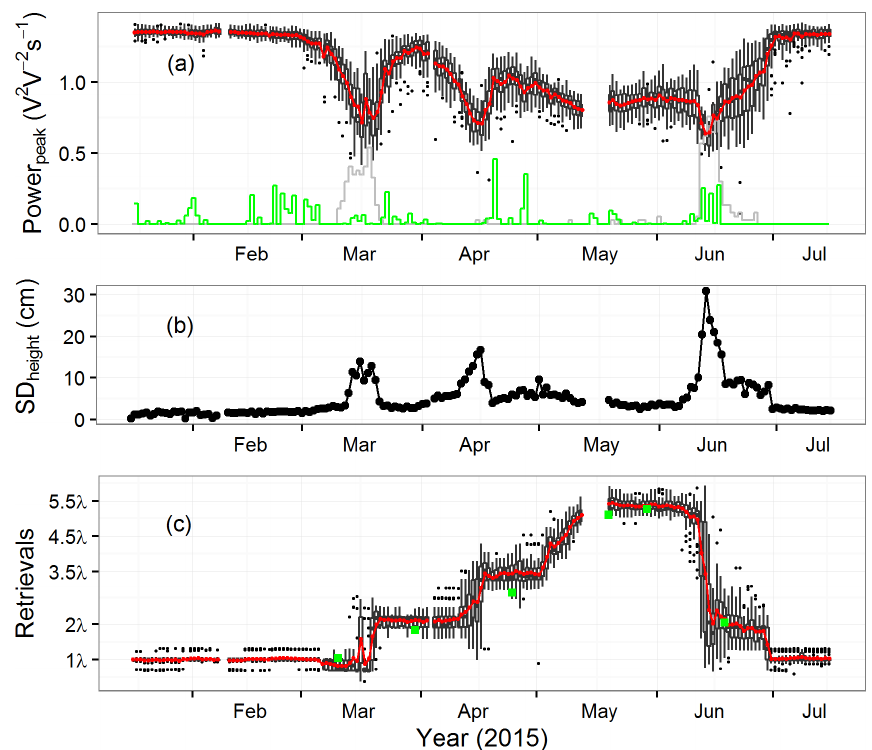
Figure 9. The box plots of (a) the peak power from a wavelet analysis, (b) standard deviation (SD) score of the retrieved vegetation height and (c) the retrieved vegetation height (rescaled in λ units) for all available satellite tracks from 16 January to 15 July 2015. The mean value of the peak power in (a) and of the retrievals in (c) are shown by red lines. In (a) , the grey line shows the statistical distribution of bad quality tracks (the number of the bad quality tracks can be obtained multiplying by 37) and the green line represents the rainfall (daily precipitation in mmday − 1 can be obtained multiplying by 50). In (c) , the rescaled in situ observations are shown by green